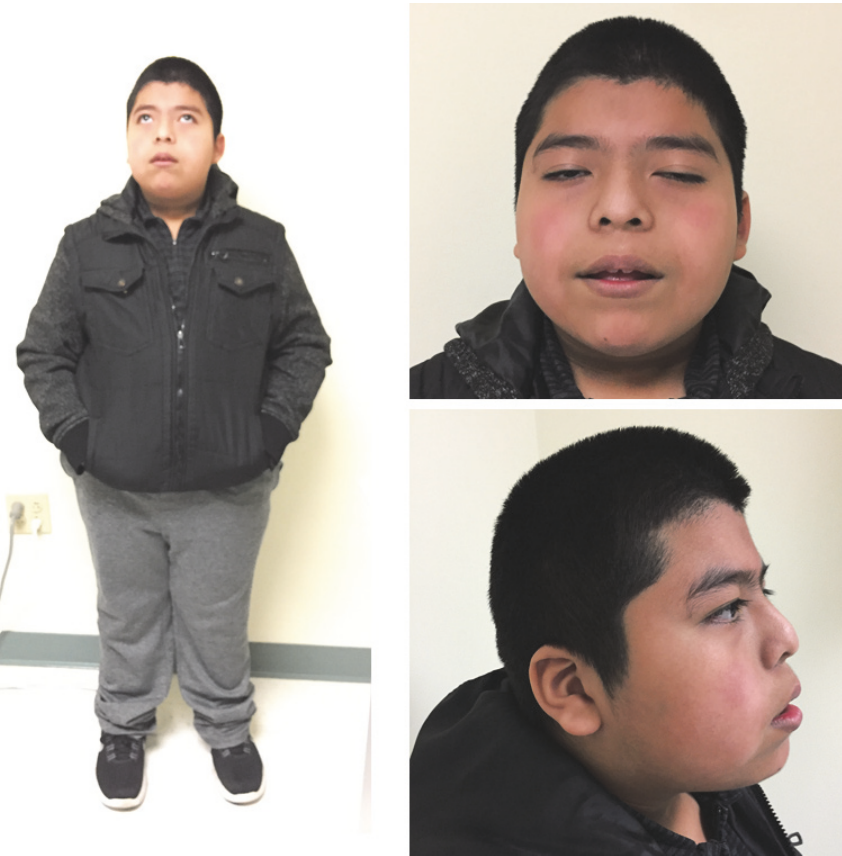
Figure 1: Index patient showing facial dysmorphism (prominent eyebrow, low set ears, midfacial retrusion, and mild prognathism).